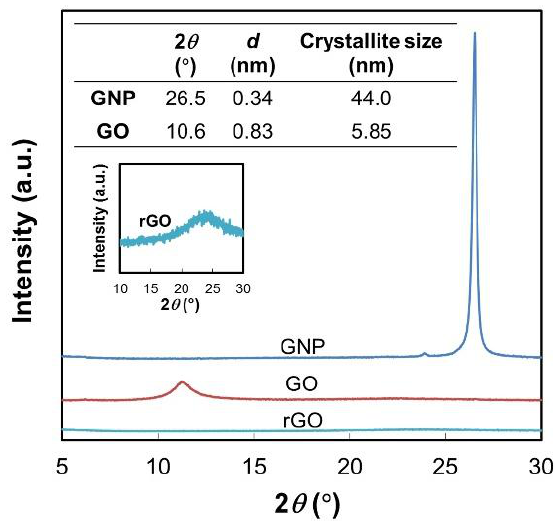
Figure 1. X-ray diffraction patterns of graphite nanoplatelets (GNP), graphene oxide (GO), and reduced GO (rGO) samples.